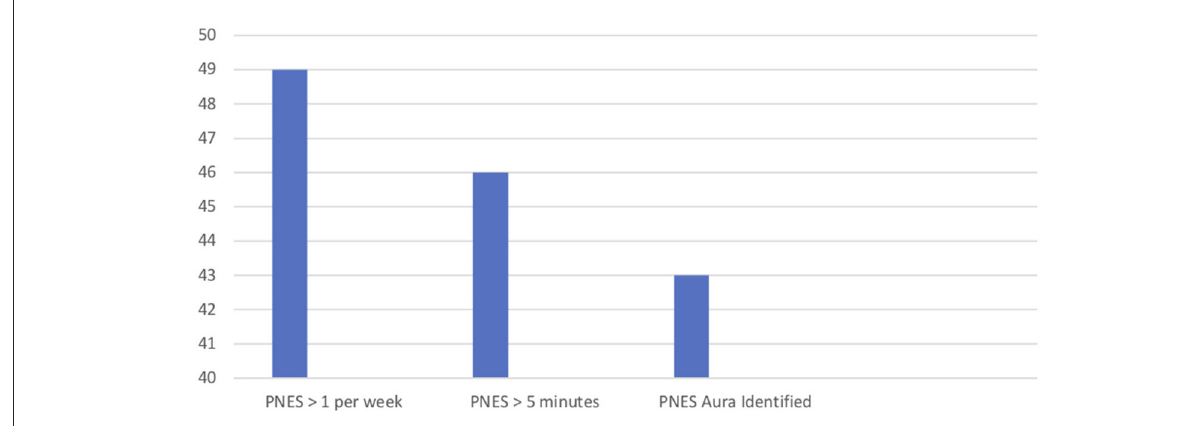
FIGURE1 PNES characteristics at evaluation. Number of patients.